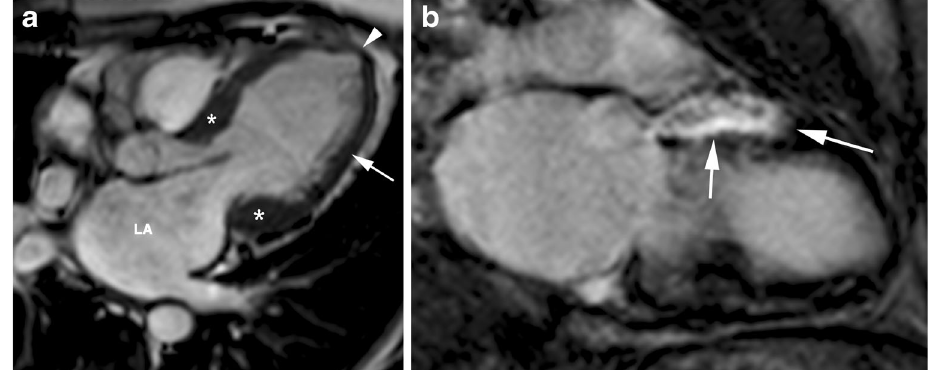
Fig. 11 Adverse remodelling. 77-year-old man with long-standing asym- metric septal and lateral HCM who presented with increasing dyspnea on exertion and palpitations. a , End-diastolic horizontal long-axis SSFP cine MR image shows dilated and dysfunctional LV (ejection fraction, 45%), moderately thickened basal septum and lateral wall (15 mm) (asterisks),